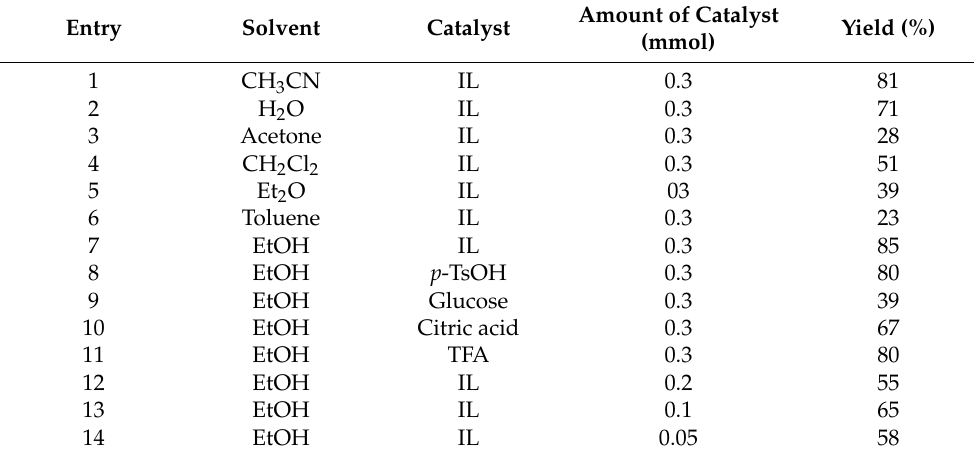
Table 1. Results of solvent and catalyst evaluation for the synthesis of 1a .